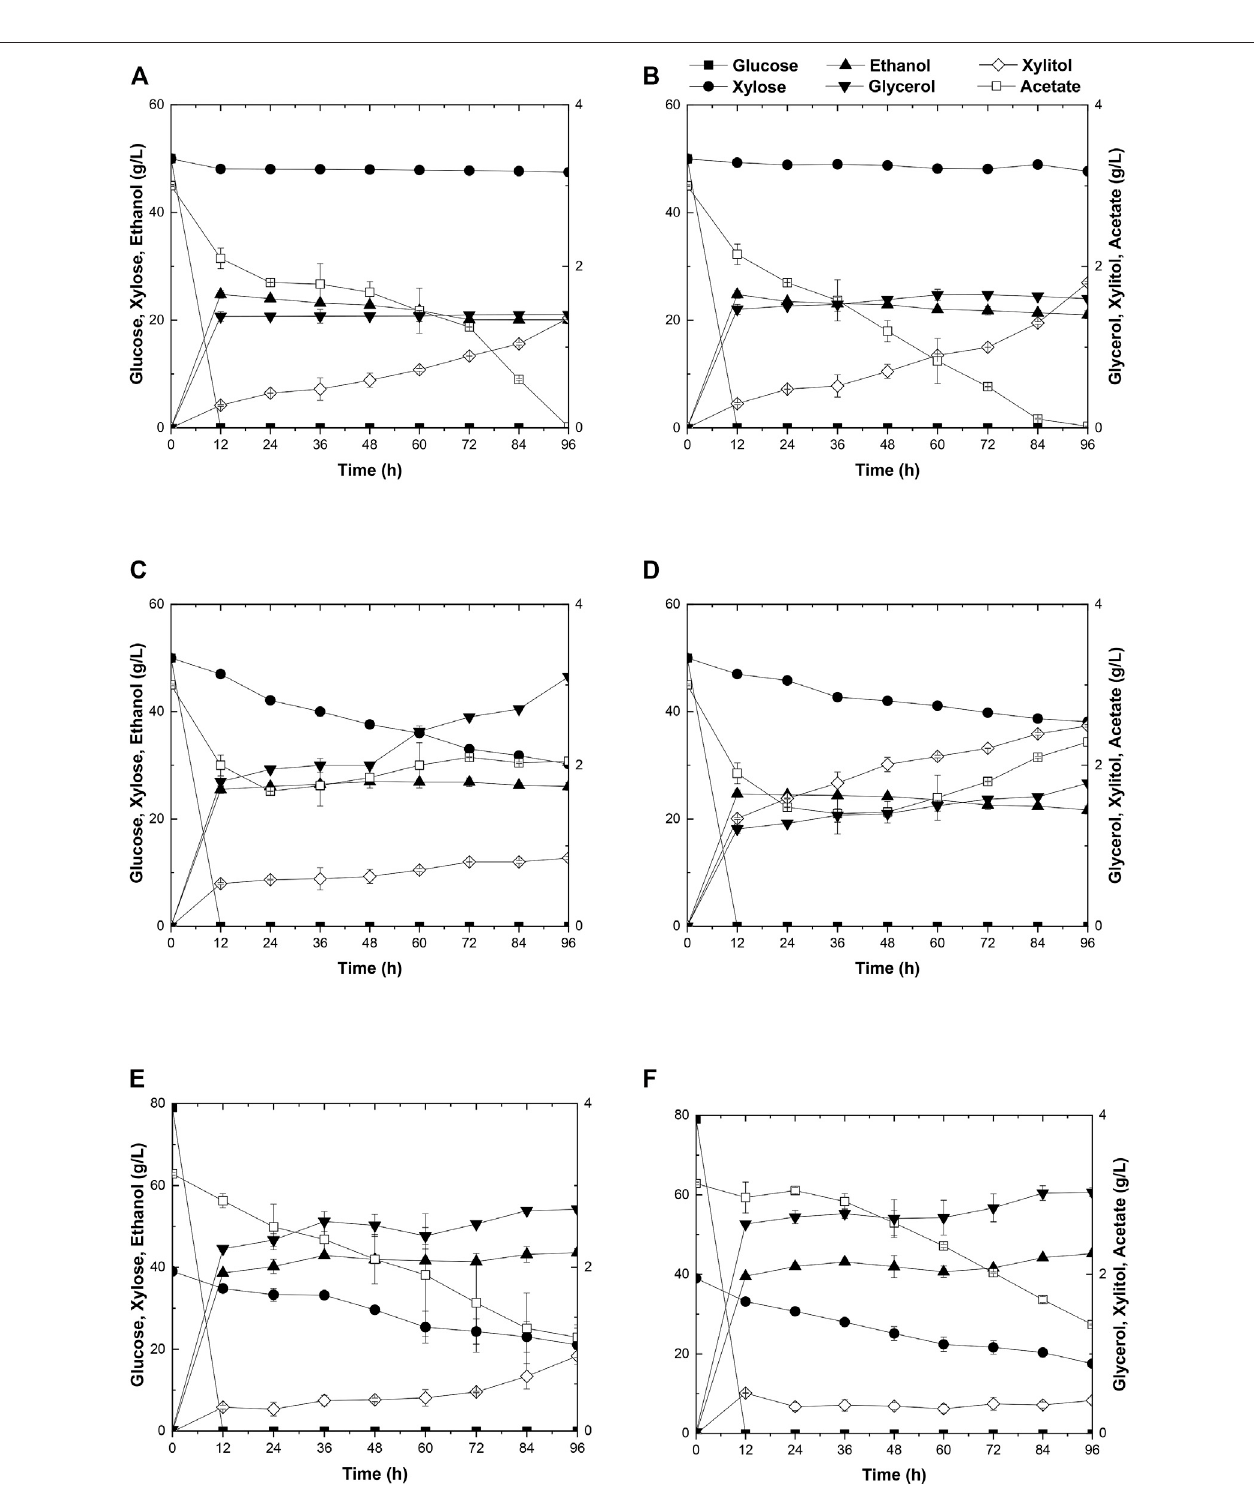
FIGURE 1 | Time-dependent ethanol fermentation of yeast strains in this study. Fermentation pro fi le of yeast Angel (A) and yeast Henderson (B) in mixed sugar medium of 50 g/L glucose and 50 g/L xylose containing 3 g/L acetate. Fermentation of ABN (C) and BBN (D) in mixed sugar medium of 50 g/L glucose and 50 g/L xylose containing 3 g/L acetate. Fermentation pro fi le of A1 (E) and A2 (F) in YP medium containing 3 g/L acetate, 80 g/L glucose, and 40 g/L xylose. Each experiment was repeated three times, and two parallel controls were set at the same time.